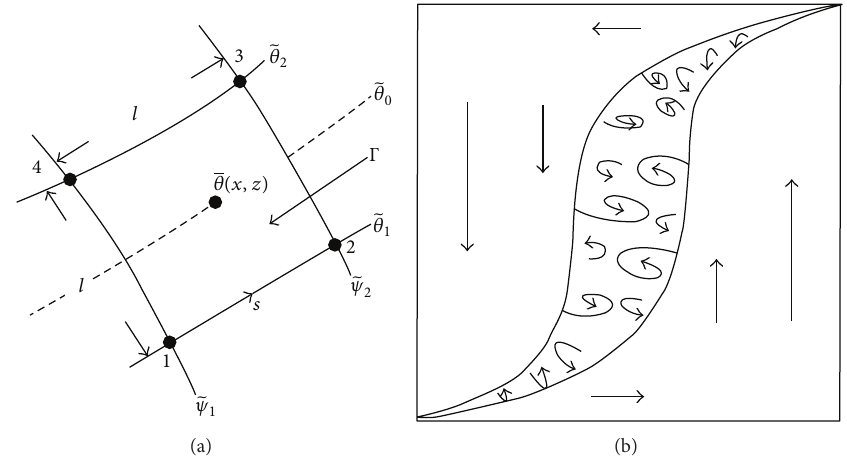
Figure 6: Averaging the flow in a net of dimensions 𝑙 and 𝑠 .